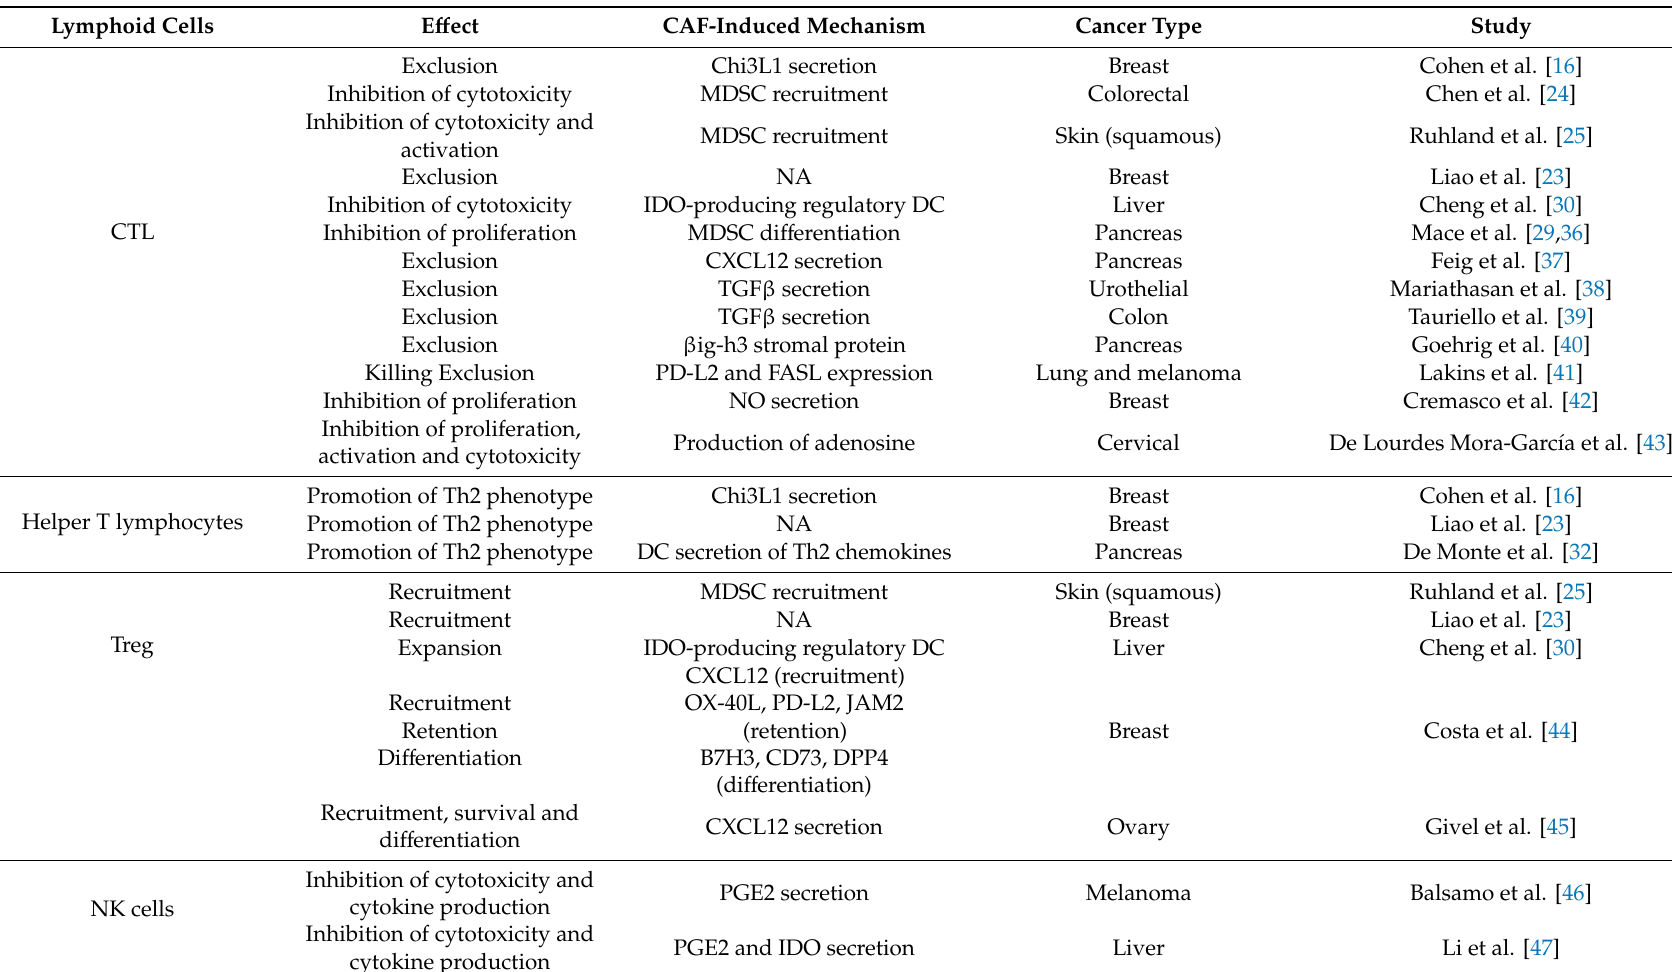
Table 2. Summary of studies evaluating modulation of lymphoid cells by cancer-associated fibroblasts 1